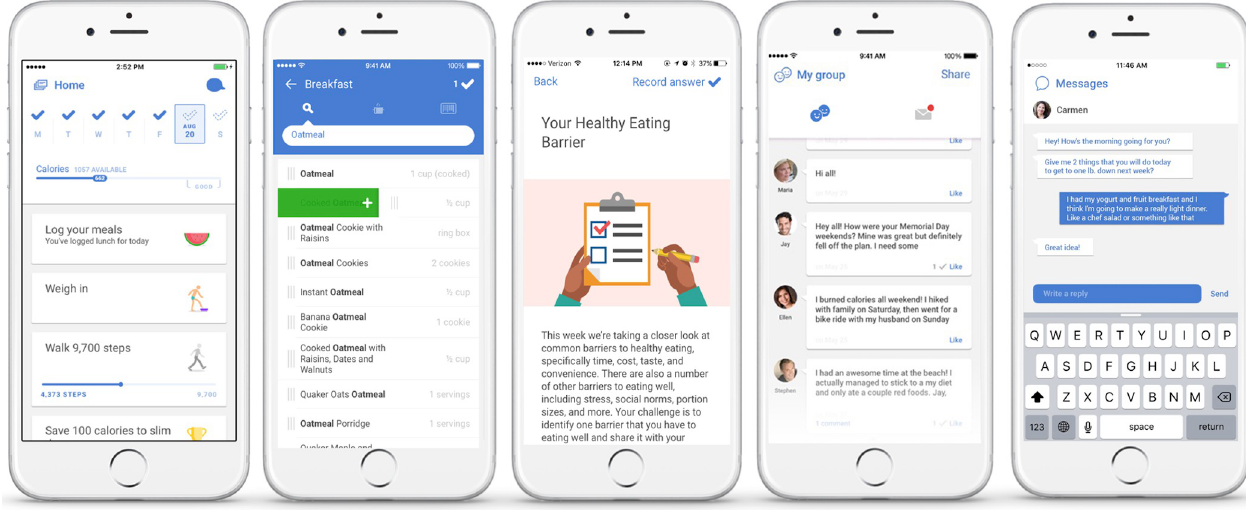
Fig 1. Screenshots of the Noom app for the participants (top) and screenshots of the dashboard for the coaches (bottom).